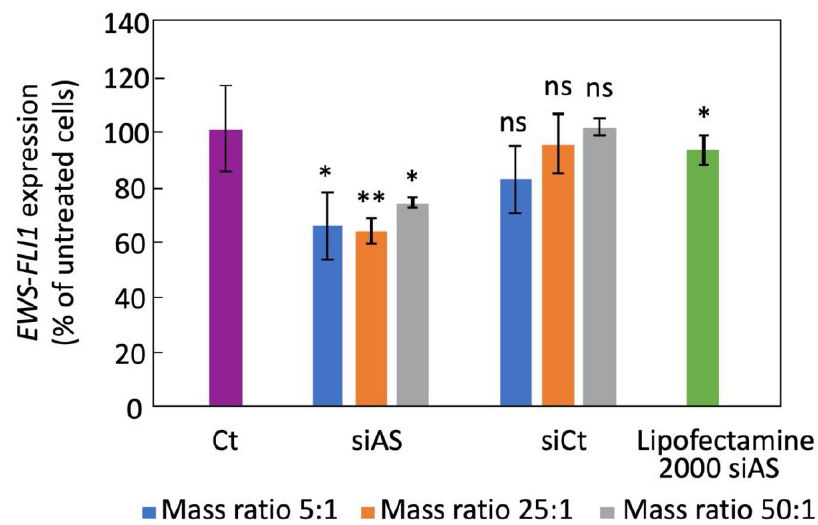
Figure 3. Inhibition of EWS-FLI1 expression in A673 Ewing sarcoma cultured cells by siRNA vectorized by H-DND (sample H-DND-24) or Lipofactamine 2000. Cells are treated during 24 h in DMEM medium containing 10% of fetal calf serum by 75 nM siRNA. The H-DND:siRNA mass ratio was 5:1, 25:1 or 50:1. siAS: antisense siRNA directed against EWS-FLI1 oncogene; siCt: control irrelevant siRNA